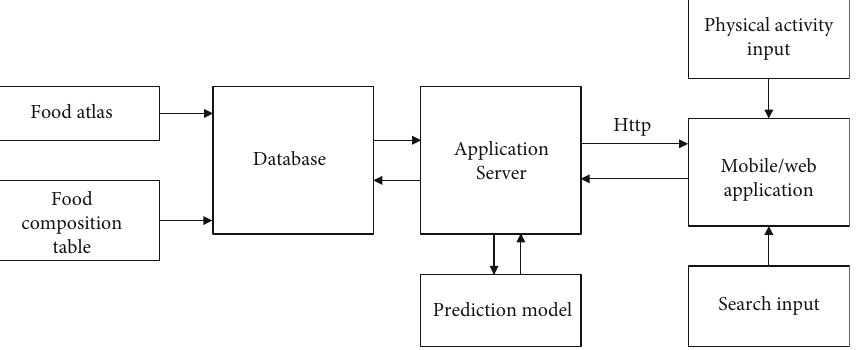
Figure 1: Architectural fl ow diagram of the obesity management